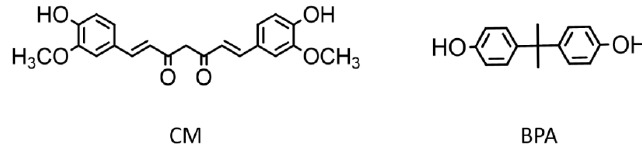
Figure 1. Structures of curcumin (CM) and bisphenol A (BPA).